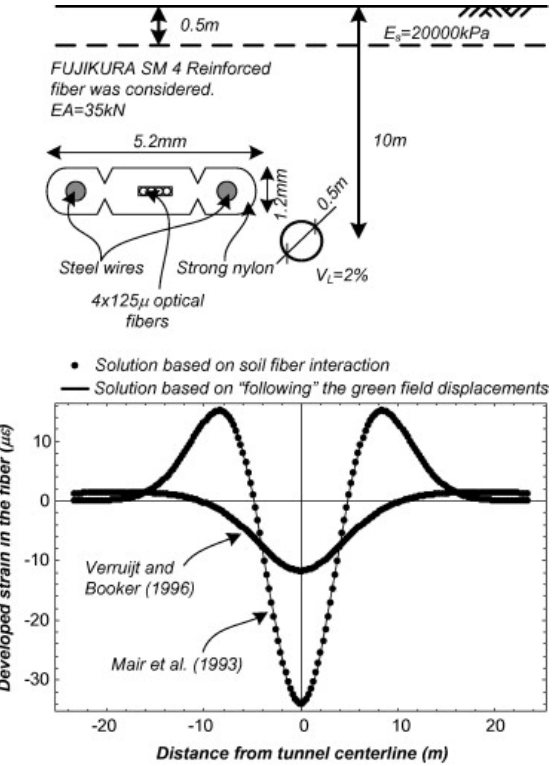
Figure 15. Above : geometry and parameters of a numerical model aimed at investigating the effect of the fibre cable on soil strain field; Below : comparison of numerical solutions obtained with and without fibre–soil interaction according to two models (reproduced with permission from